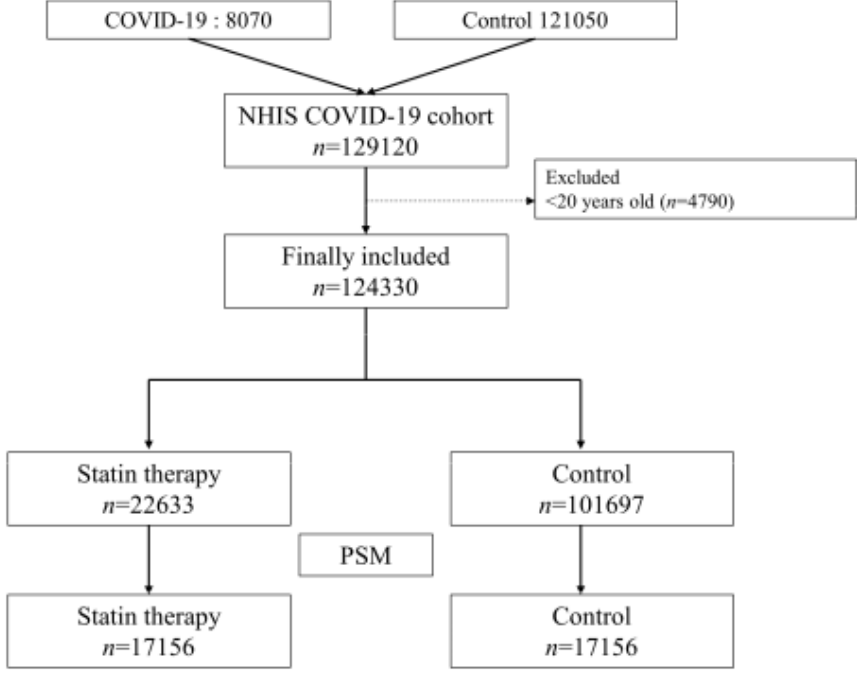
Figure 1. Flow chart depicting the process of participant selection. COVID-19, coronavirus disease- 2019; PSM, propensity score